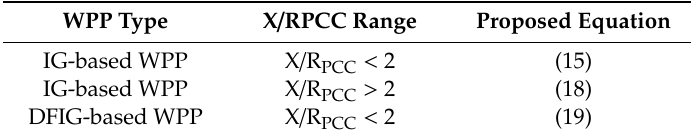
Table 9. Best fit functions considering WPP type and X / R PCC